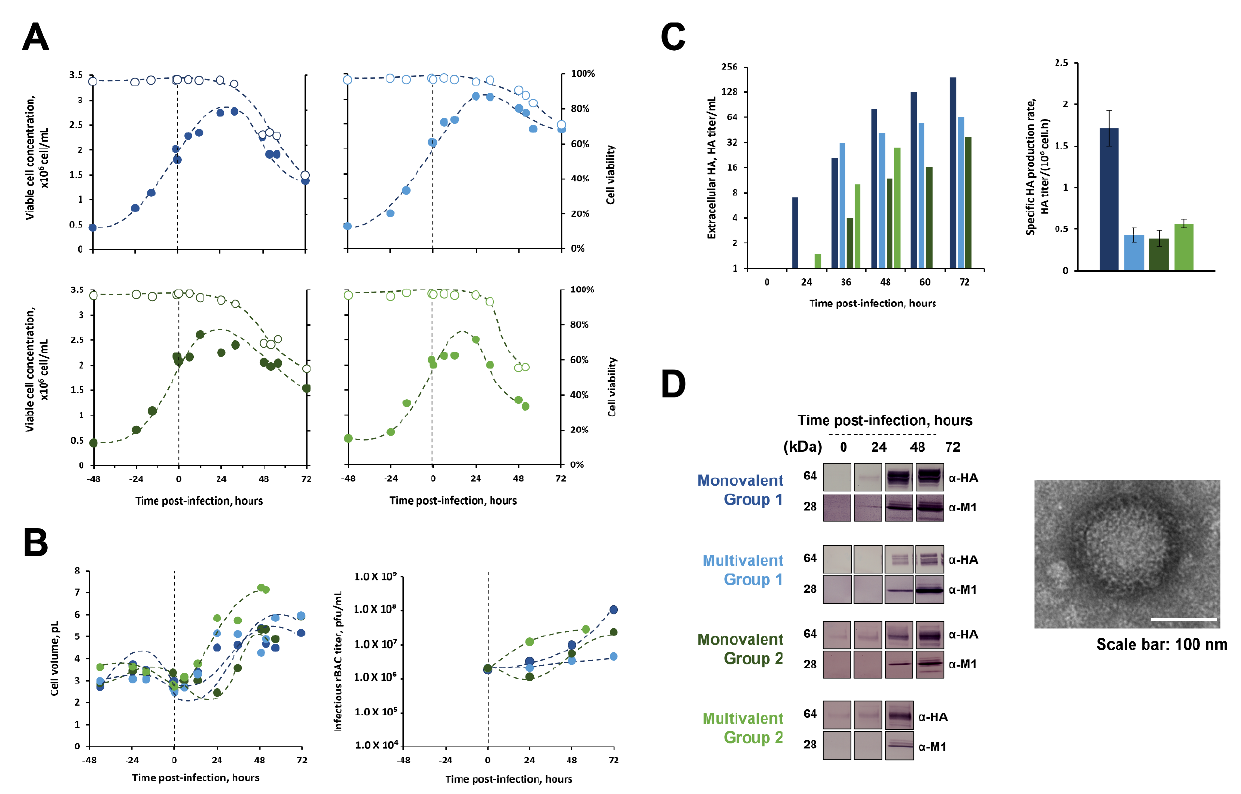
(Figure 2D—left panel), and the presence of particles resembling influenza HA-VLPs, both in size and morphology, was confirmed by TEM (Figure 2D—right panel).